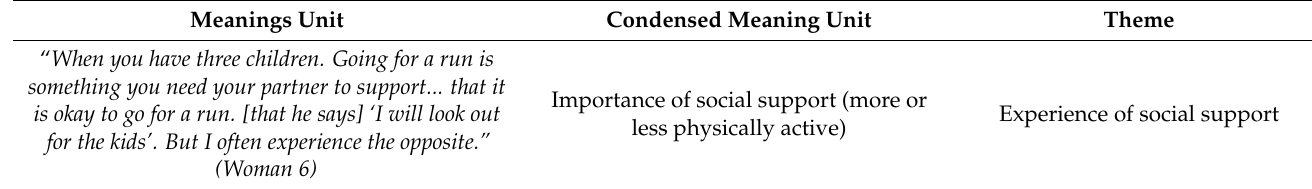
Table 2. Example of meaning units and their associated category and theme. Meanings